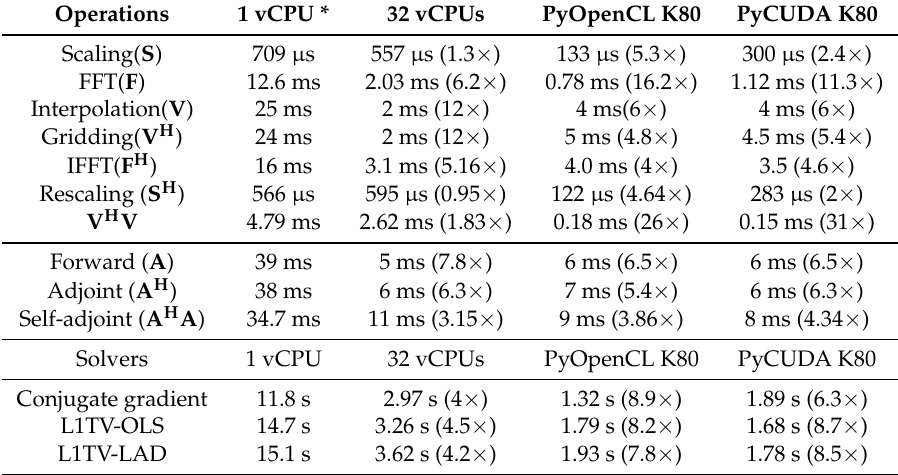
Table 1. The runtime and acceleration (shown in parentheses) of subroutines and solvers.